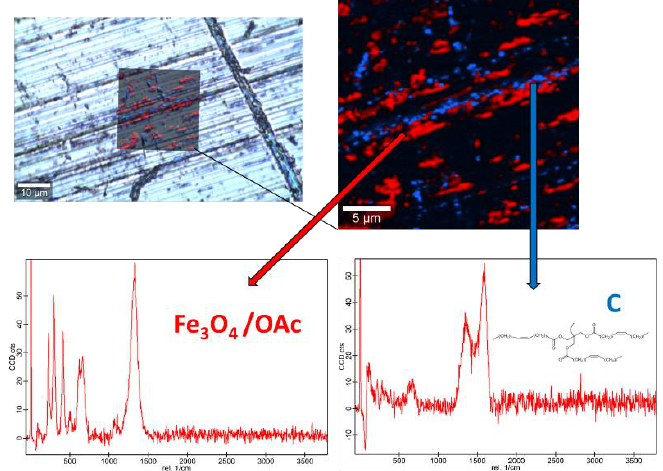
Figure 12. Raman spectra and elemental mapping of the worn surface obtained with the nanolubricant of Fe 3 O 4 (6.3 nm) nanoparticles.